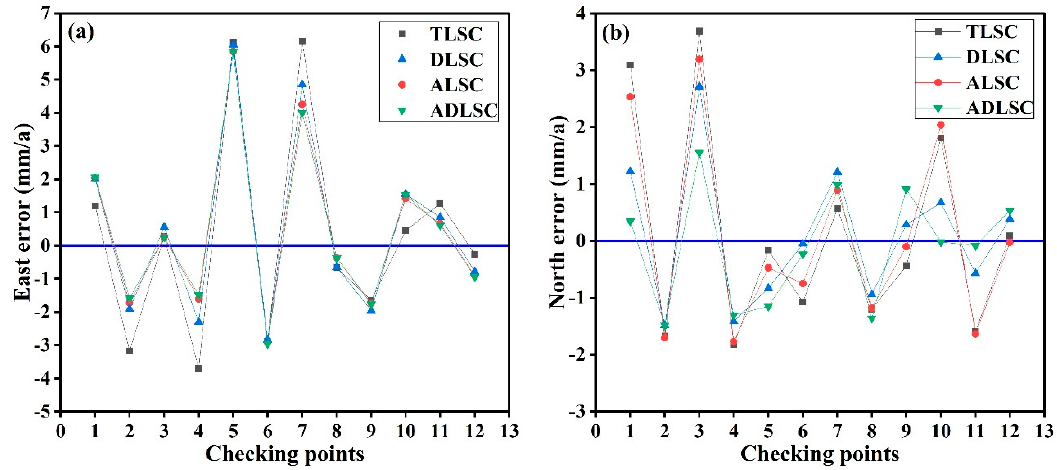
Figure 3. Residual between the estimated and observed velocity of the checking points: ( a ) east direction; ( b ) north direction.